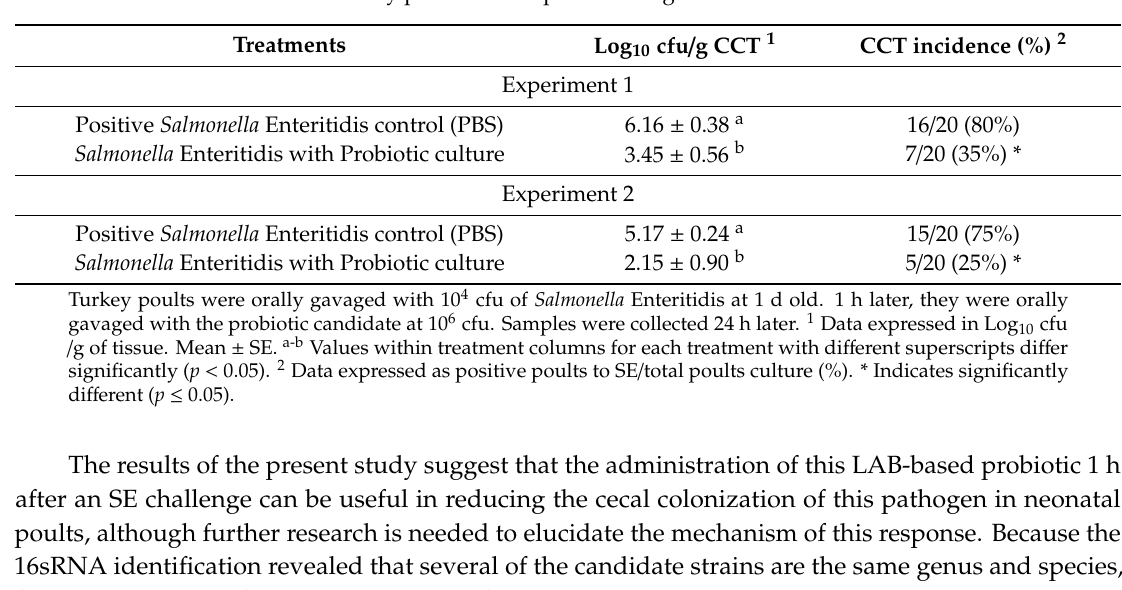
Table 2. Evaluation of the lactic acid bacteria probiotic candidate on ceca-cecal tonsils (CCT) colonization of Salmonella Enteritidis in turkey poults at 24 h post